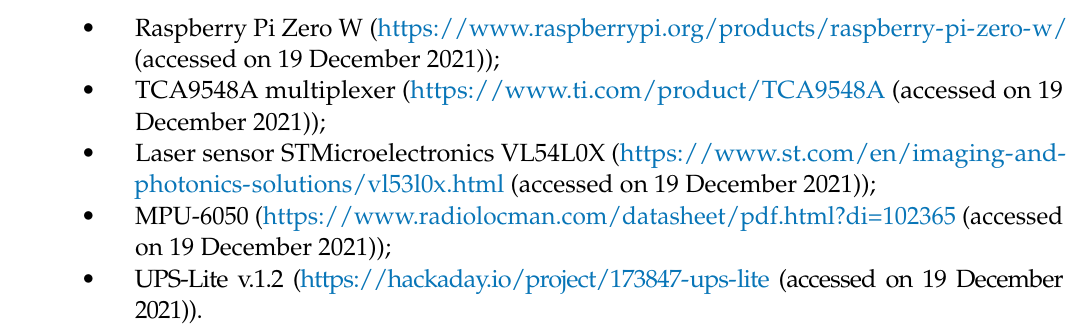
ice skating and roller/inline skating, the majority of falls are in a forward direction. Skaters attempt to break their falls with their arms or hands in over 90% of falls in both ice skating (93.1%) and roller/inline skating (94.5%) [4]. The control unit was worn together with